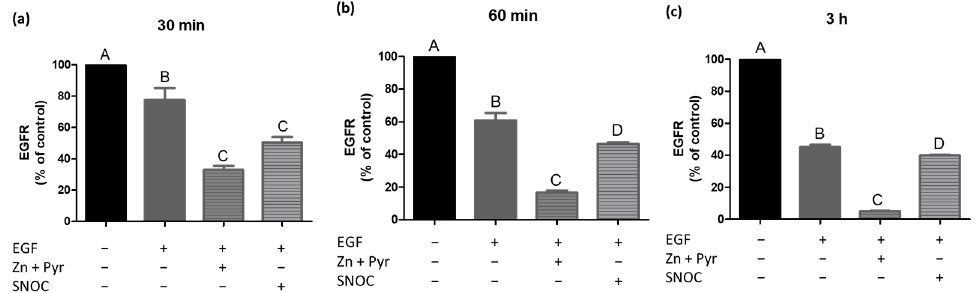
Figure 6. Zinc supports EGF-induced reduction of EGFR surface expression. The effect of a simultane-